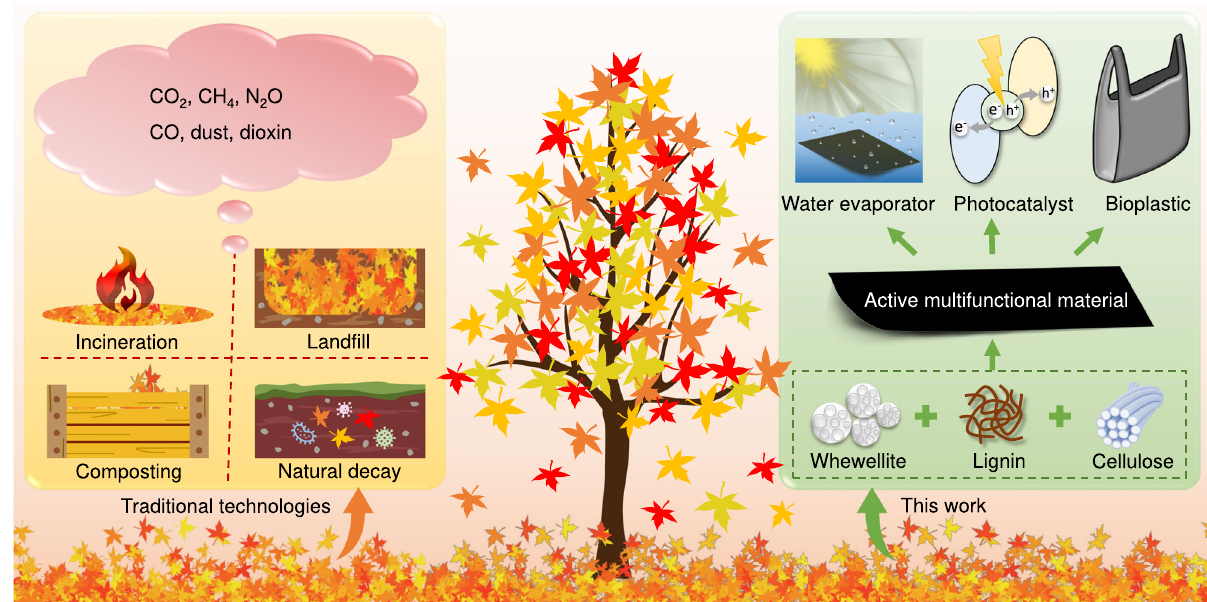
Fig. 1 | Schematic illustration of technologies for treating dead leaves. Comparison of the approach developed in this work with traditional technologies.